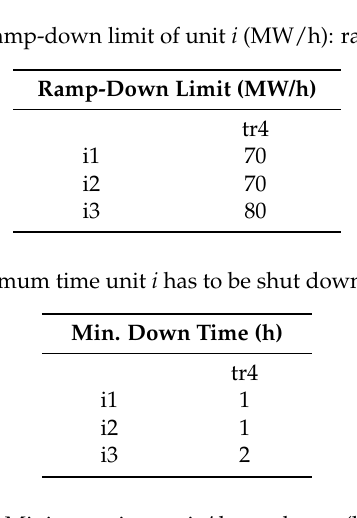
Table A12. Minimum time unit i has to be up (h): g_up( i ).